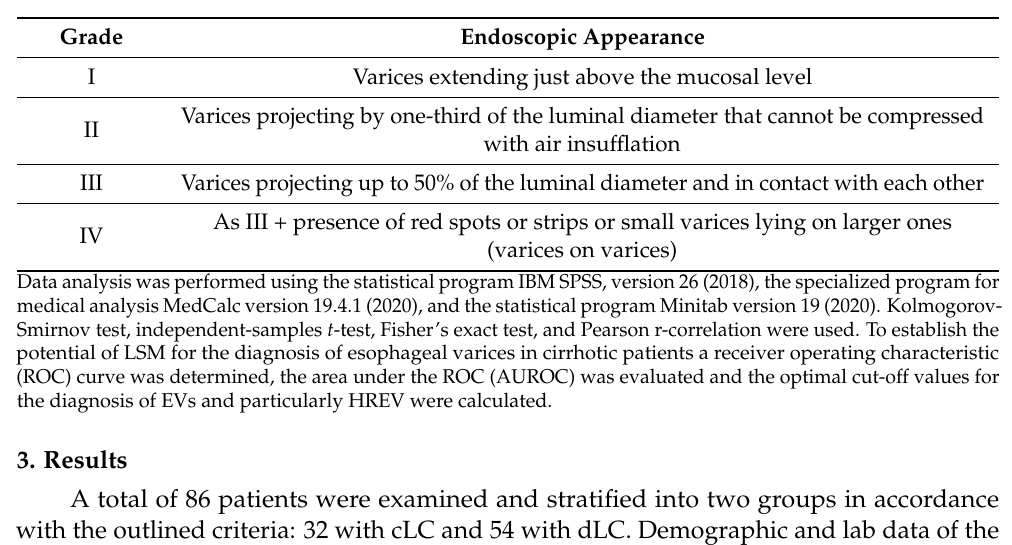
Table 1. Paquet classification of